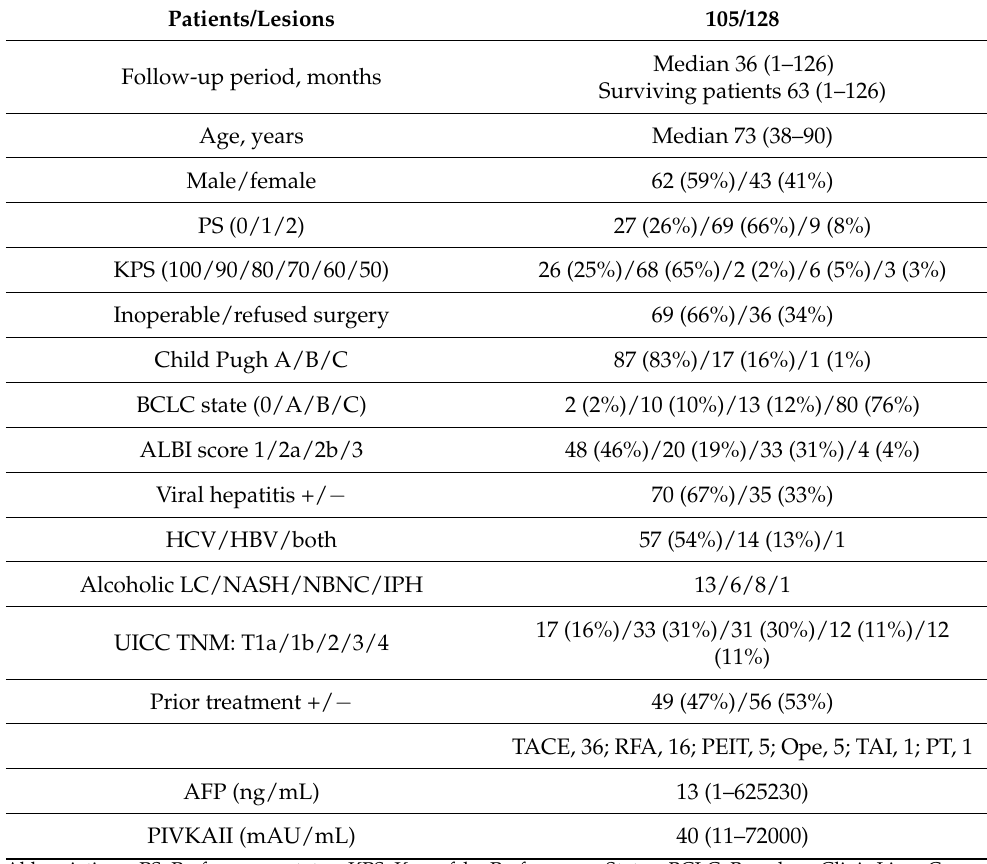
Table 1. Baseline characteristics of 105 patients who underwent image-guided proton therapy for hepatocellular carcinoma.